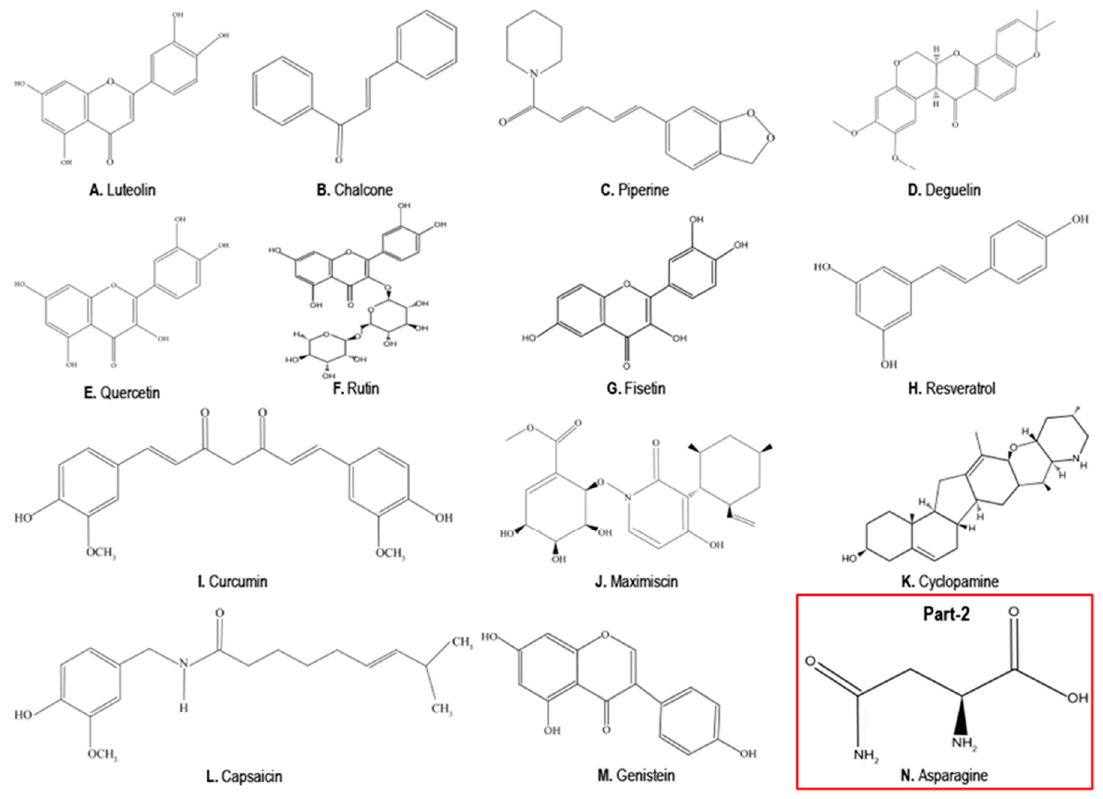
Figure 2. Chemical structures of the natural compounds. Image (Part 1) shows the chemical structures of the natural compounds (A. Luteolin, B. Chalcone, C. Piperine, D. Deguelin, E. Quercetin, F. Rutin, G. Fisetin, H. Resveratrol, I. Curcumin, J. Maximiscin, K. Cyclopamine, L. Capsaicin, and M. Genistein) with potential anticancer properties in TNBCs. Image Part 2 (in red box) shows the chemical structure of N. Asparagine which supports the growth and metastasis of TNBCs.